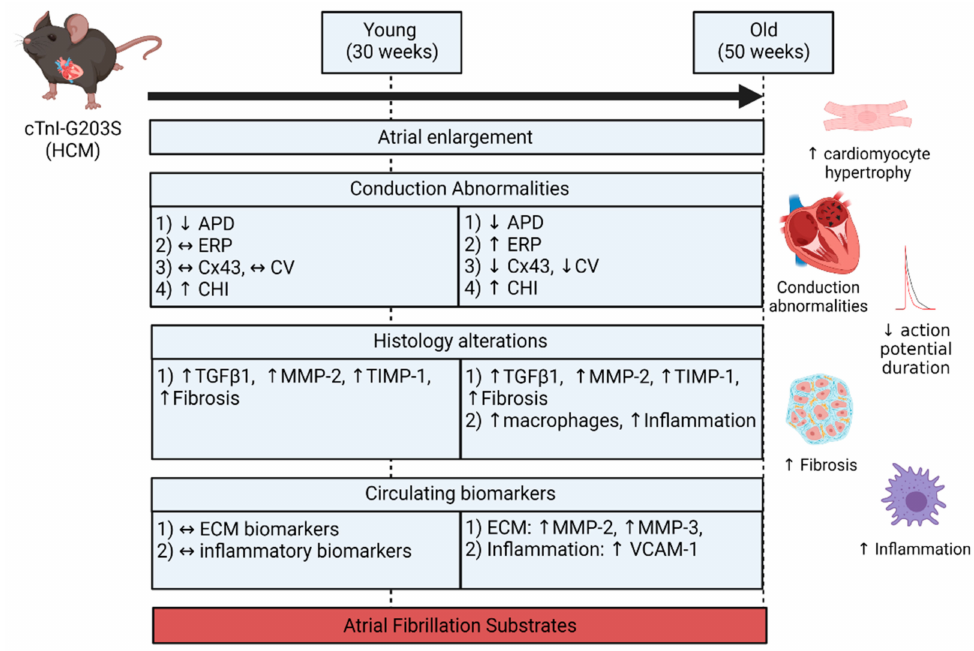
Figure 6. Summary of atrial conduction, histological, and circulating biomarker alterations in the troponin I (TnI) mutant mouse model of HCM. Created with BioRender.com on 17 June